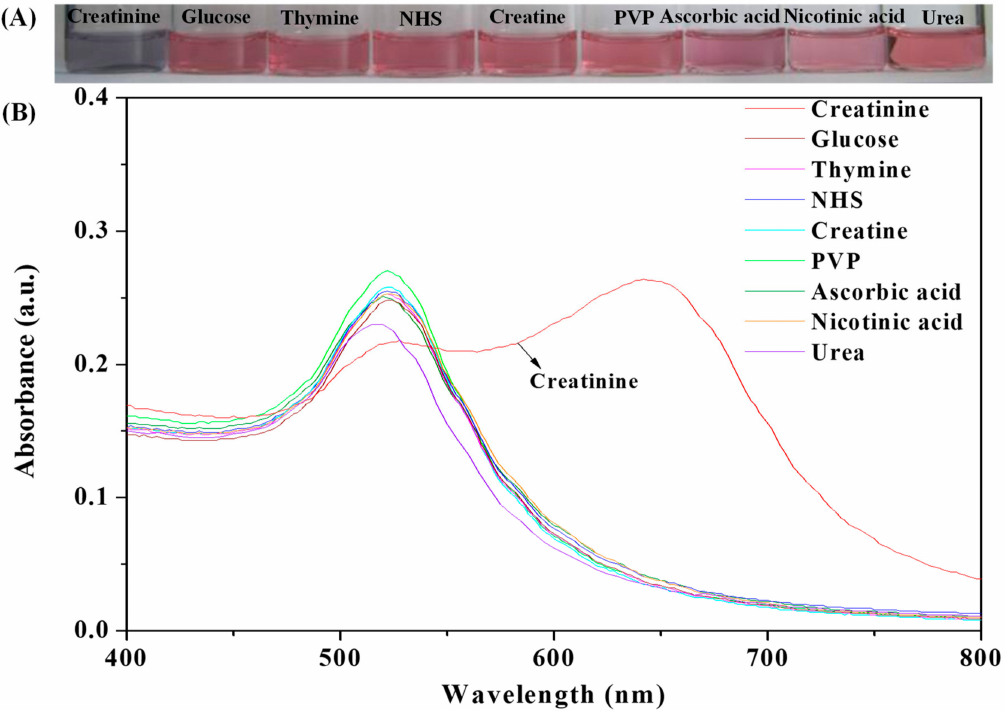
Figure 6. Selectivity of PEG / Hg 2 + –AuNP probe: ( A ) photographs and ( B ) absorption spectra of the solution contain 0.798 nM AuNPs, 0.1 mM Hg 2 + , and 0.67 mM PEG upon the addition of 25 µ M creatinine (C 4 H 7 N 3 O) and many other molecules having similar structures as creatinine, including urea (CO(NH 2 ) 2 ), N-N-hydroxysuccinimide (NHS) (C 4 H 5 NO 3 ), thymine (C 5 H 6 N 2 O 2 ), polyvinyl pyrrolidone (PVP) ((C 6 H 9 NO) n ), ascorbic acid (C 6 H 8 O 6 ), creatine (C 3 H 7 NO 2 ), nicotinic acid (C 6 H 5 NO 2 ), and glucose (C 6 H 12 O 6